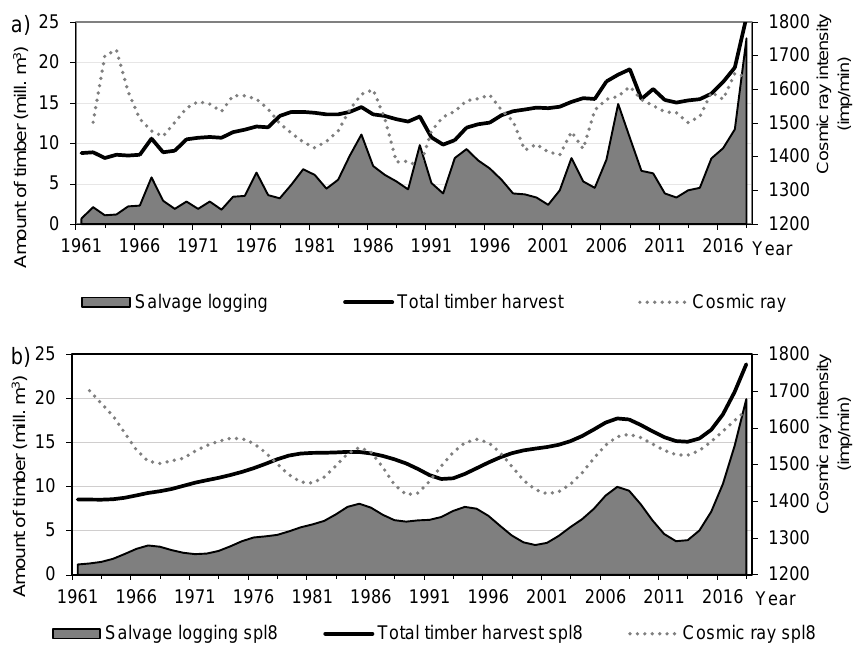
Figure 8. Average annual data on cosmic ray intensity in relation to the volume of timber harvested in the Czech Republic; ( a ) The trend of total and salvage logging according to their causes in relation to cosmic ray intensity; ( b ) an eight-year spline (spl8) fitted to harvested timber and cosmic ray intensity; imp/min—impulses/minute; mill. m 3 —million cubic meters of harvested timber.